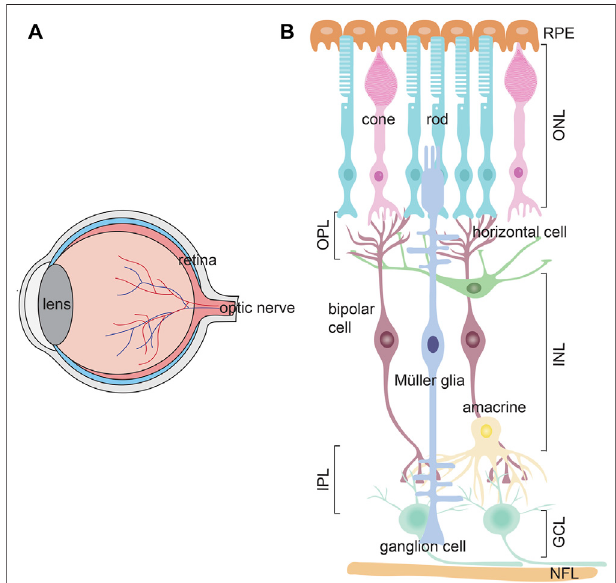
FIGURE5| Retinalstructure (A) Schematicoftheeye,showingthelens, retina and optic nerve (B) Schematic of the three retinal cell layers; ganglion cell layer (GCL), inner nuclear layer (INL), and outer nuclear layer (ONL). The ONL contains rod and cone photoreceptors, which process light information. The INL contains three interneuron types – amacrine cells, bipolar cells, and horizontal cells, which modulate signals from photoreceptors, and transmitthis information toganglioncells intheGCL. Ganglion cellaxonsform a nerve fi ber layer (NFL) and project to the brain. Müller glia (mg) are the main retinal glia with nuclei residing in the INL. There are two plexiform layers where synapses form – the outer plexiform layer (OPL) and inner plexiform layer (IPL). The apical side of the retina is covered by a retinal pigment epithelium (RPE).